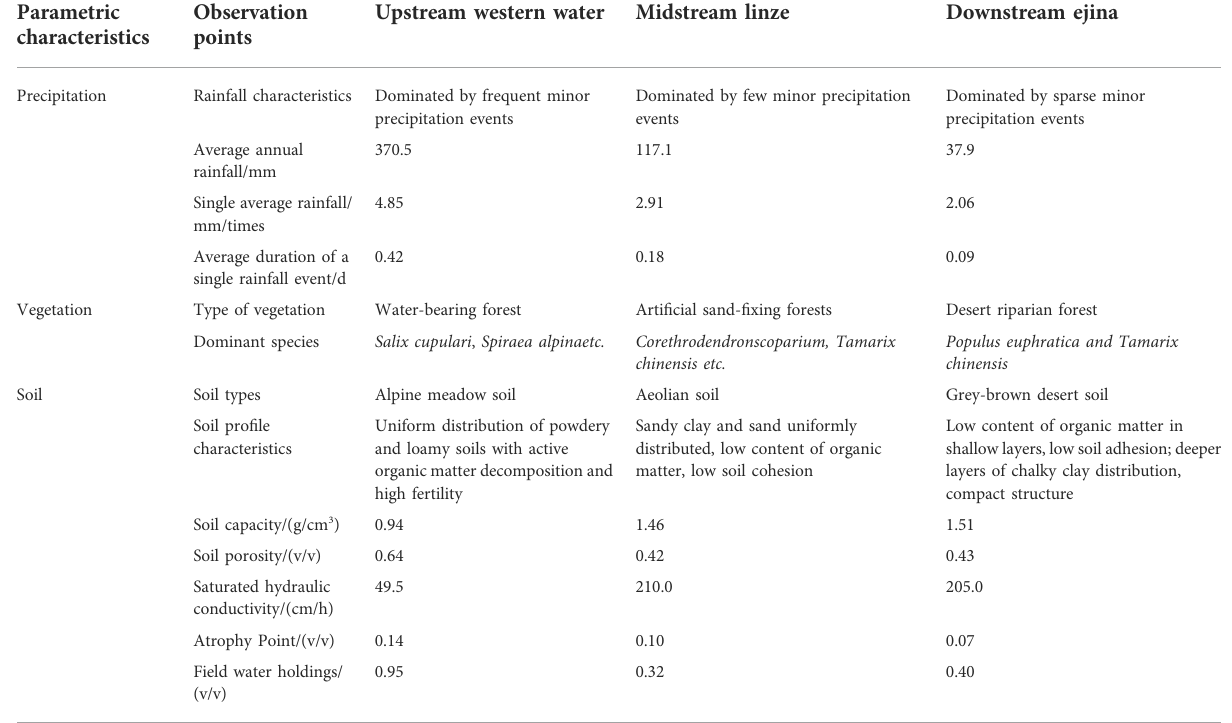
TABLE 1 Characteristics of precipitation, vegetation, and soil in typical landscape belts in upper, middle, and lower reaches of Heihe river